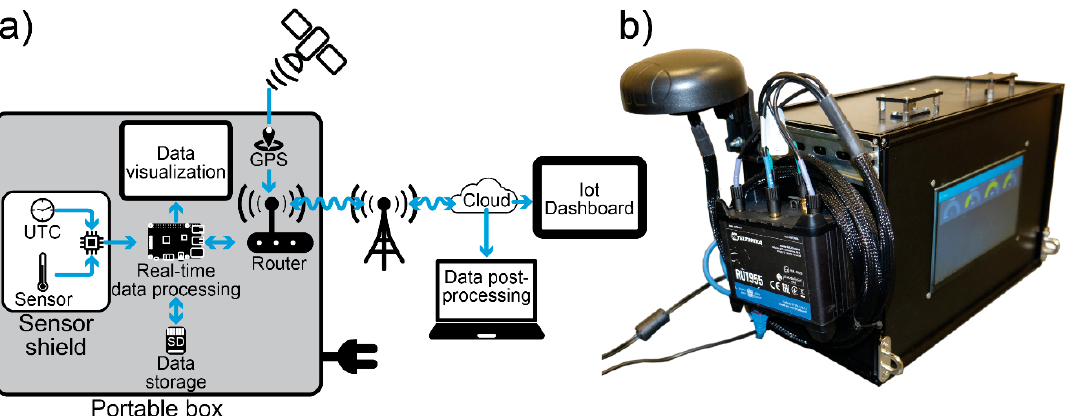
Figure 1. Overview of the sensor box. ( a ) General architecture of the sensor box where all sensors are attached to a sensor shield and that communicates with the Raspberry Pi; ( b ) Photo of the sensor box with the router and the screen incorporated in the side of the sensor box.